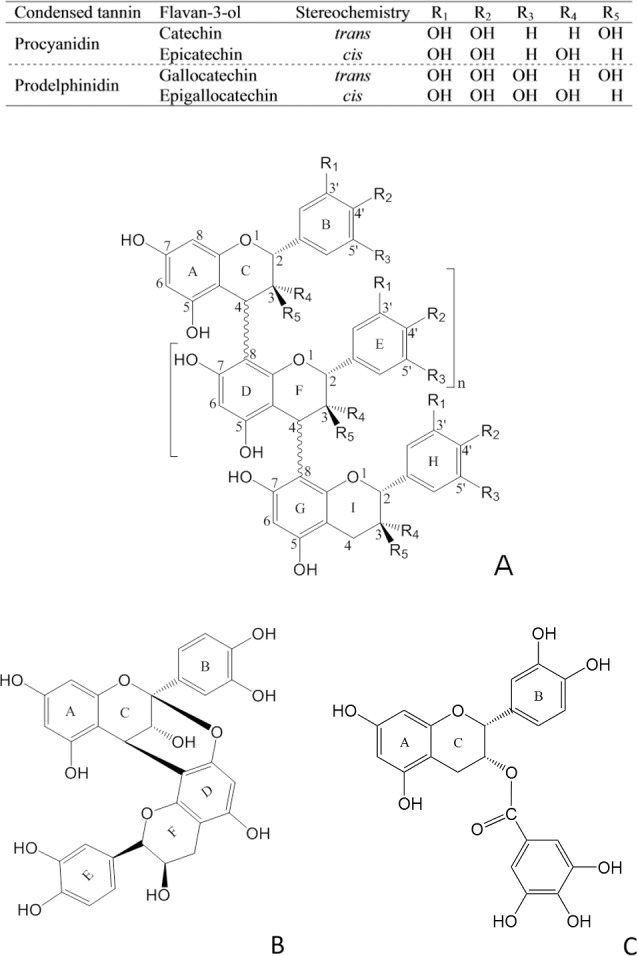
Examples of condensed tannins and a galloylated flavan-3-ol.(A) a B-type condensed tannin; (B) an A-type condensed tannin, epicatechin(4ß→8, 2ß→O→7)-epicatechin; and (C) a flavan-3-ol monomer, epicatechin gallate.